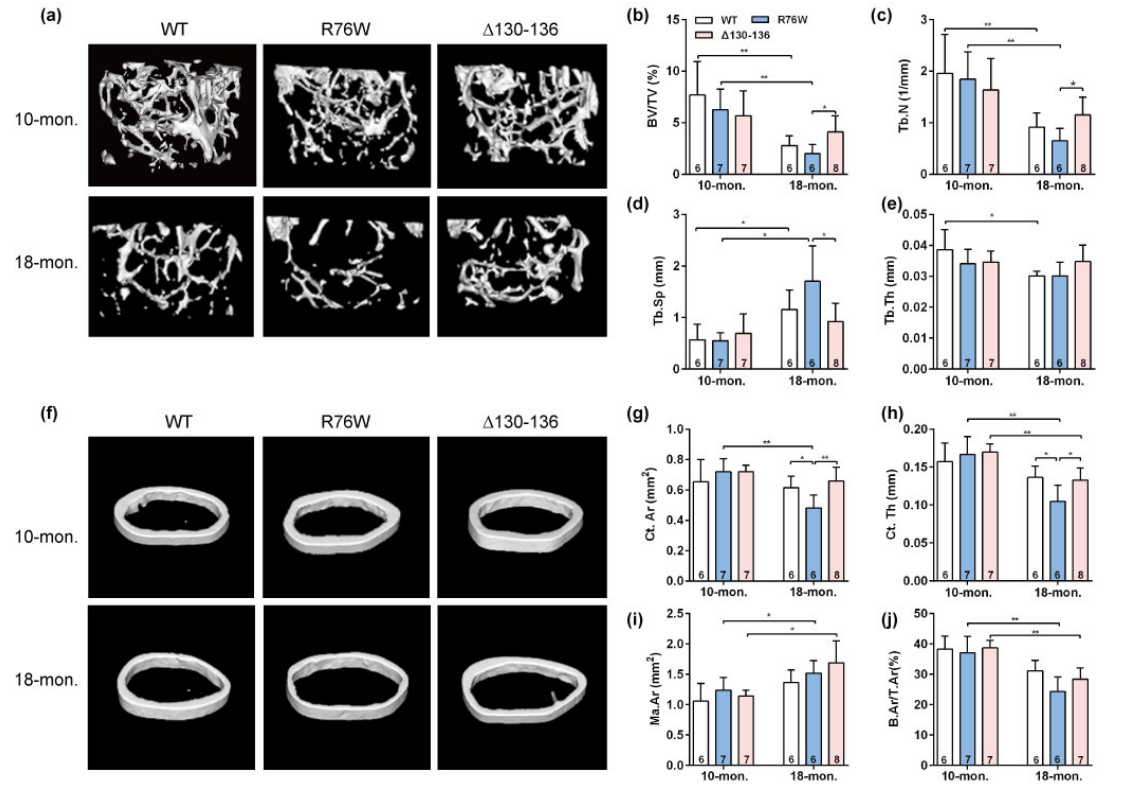
Figure 1. Enhancement of Cx43 HCs while GJs are inhibited decreases bone mass in 18-month-old mice. ( a ) Representative µ CT images of femoral trabecular microarchitecture. ( b – e ) Trabecular microstructural parameters, including BV/TV ( b ), Tb.N ( c ), Tb.Sp ( d ) and Tb.Th ( e ), were shown. ( f ) Representative µ CT images of femoral cortical microarchitecture. (Jung-Jun, Berggren, Hulver, Houmard, and Hoffman) Cortical microstructural parameters at the midshaft femur, including Ct.Ar ( g ), Ct.Th ( h ) Ma.Ar ( i ) and B.Ar/T.Ar ( j ) were shown. Sample sizes are indicated at the bottom of each column. BV/TV = bone volume fraction; TB.N = trabecular thickness; Tb.Sp = trabecular separation; Tb.Th = trabecular thickness; Ct.Ar = cortical area; Ct.Th = cortical thickness; Ma.Ar = marrow area; B.Ar = bone area; T.Ar = total area. * p < 0.05; ** p <